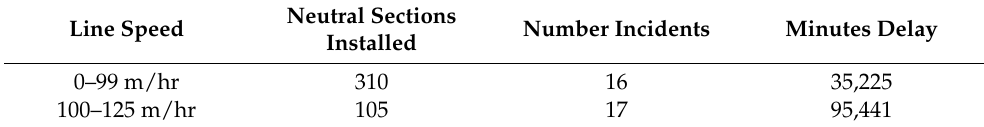
Table 3. Network Rail neutral section population and failures by line speed, 2006–2015